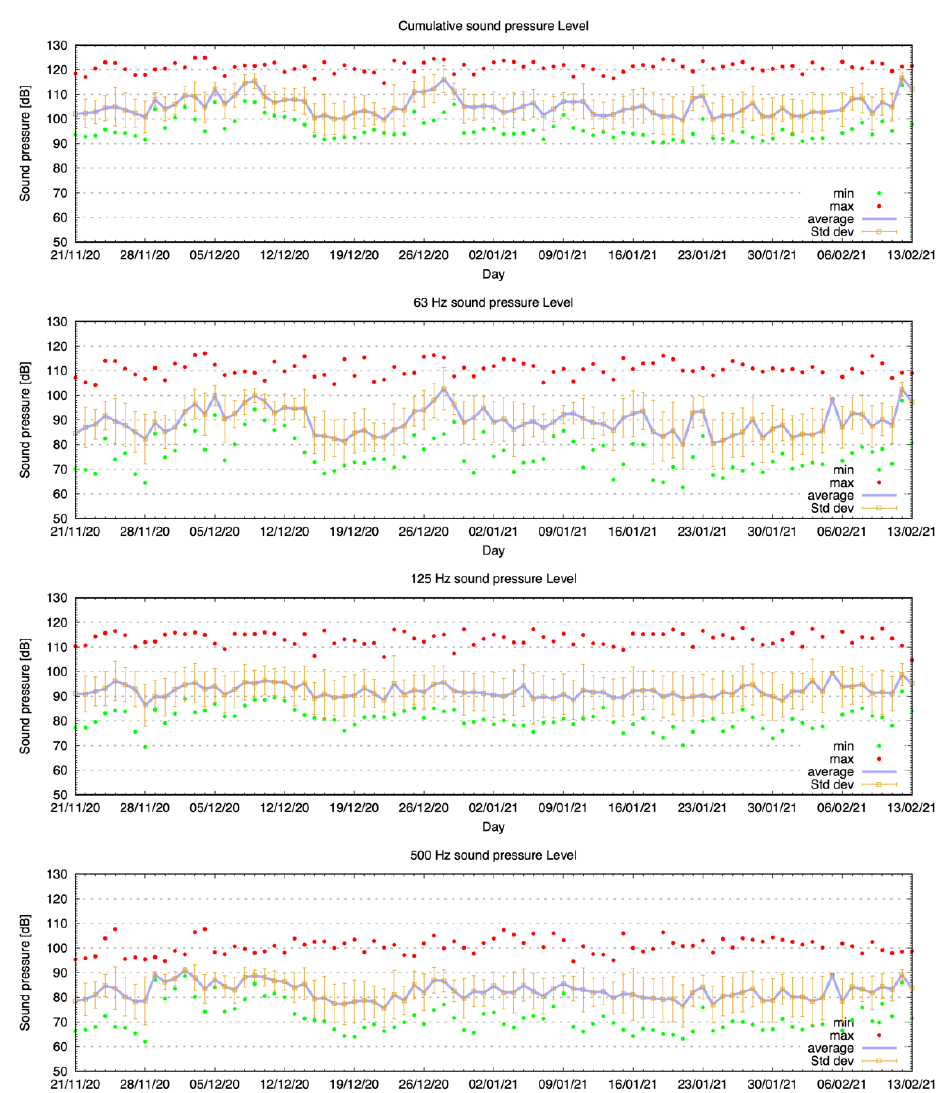
Figure 11. Plot of the minimum (green dots), maximum (red dots), average value (purple line), and standard deviation (whiskers) of the SPL as a function of day in the range between 11/21/2020 to 13/2/2021, and similarly for the 63, 125, and 500 Hz one-third octave bands.